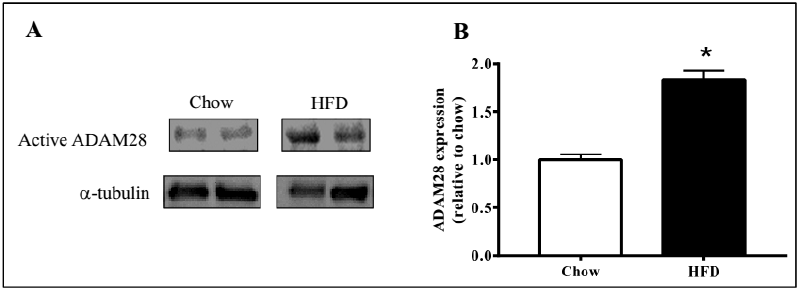
Figure 3. Elevated ADAM28 expression levels in high fat fed mice. Active ADAM28 (42 kDa) protein levels were measured by immunoblotting ( A ) and quantified based on densitometry ( B ) in livers of mice on a high fat diet for 12 weeks * p < 0.05; n = 3–4 mice/group.